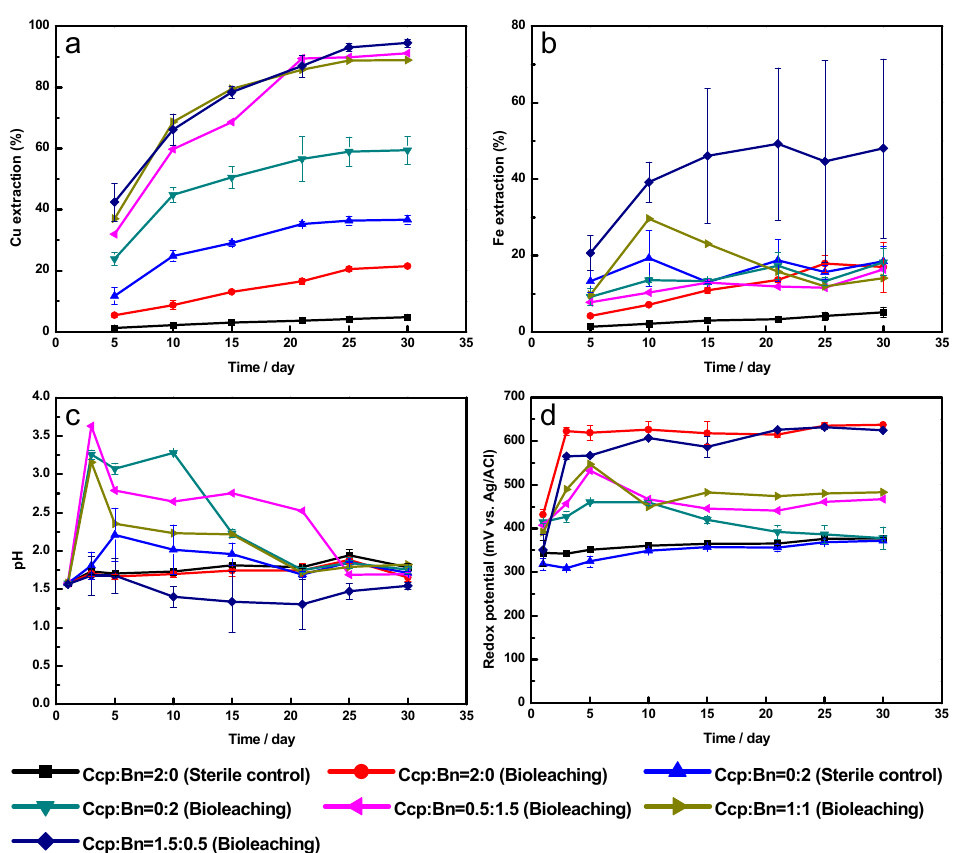
Figure 1. Copper extraction ( a ); iron extraction ( b ); pH ( c ) and redox potential ( d ) in leach liquors during the leaching process.